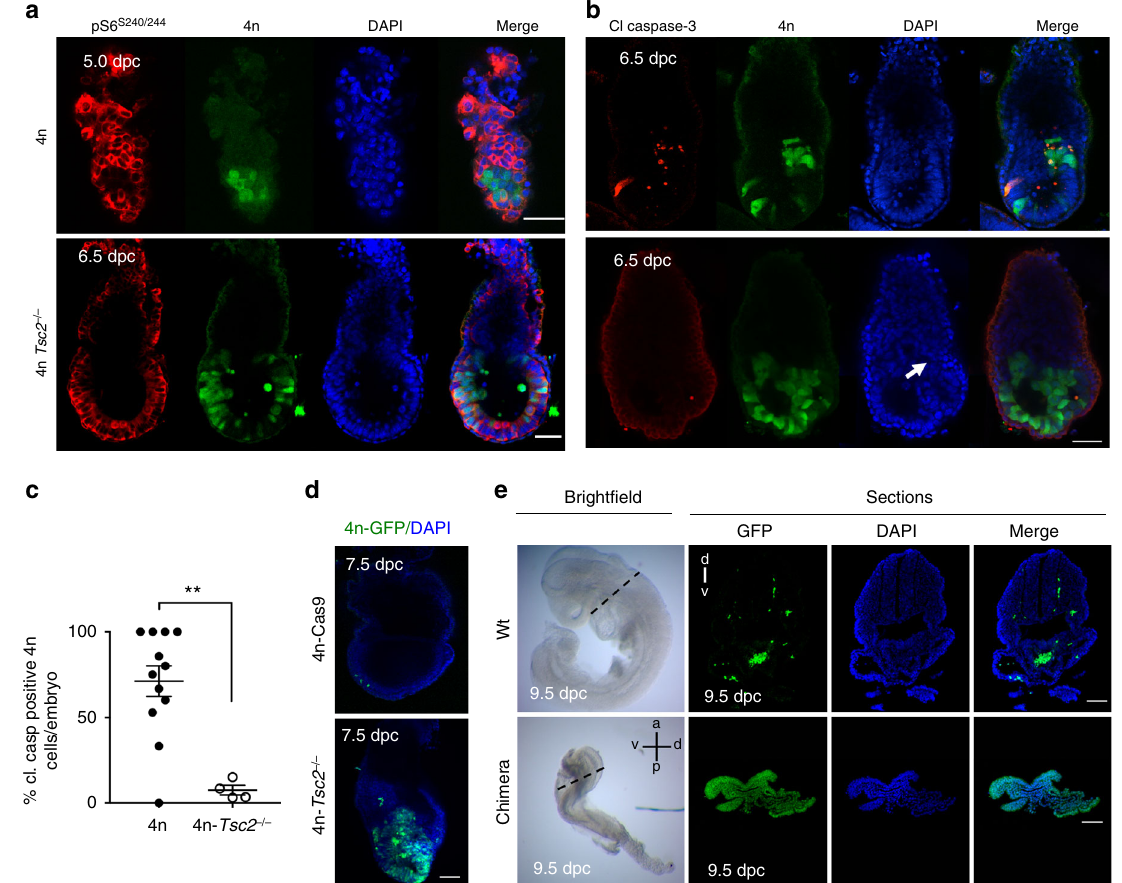
Fig. 5 mTOR pathway repression is required for competition in vivo. a Chimeras generated by injecting 4n and 4n- Tsc2 − / − cells into wild-type blastocysts. Levels of pS6 were analysed at 5.0 dpc and 6.5 dpc, respectively. b Chimeras generated by injecting 4n ( n = 12) and 4n- Tsc2 − / − ( n = 4) cells into wild-type blastocysts. The white arrow indicates epiblast overgrowth of 4n- Tsc2 – / – cells in these chimeras. Levels of cell death were assessed by cleaved caspase-3 staining at 6.5 dpc and quanti fi ed ( c ). d Chimeras generated by injecting 4n-Cas9-GFP and 4n- Tsc2 − / − -GFP cells into wild-type blastocysts. Embryos were analysed for GFP expression to determine contribution of 4n cells. e 4n- Tsc2 − / − GFP cells were injected into wild-type blastocysts, embryos were collected at 9 dpc, and levels of 4n Tsc2 − / − GFP contribution were assessed by whole-mount immuno fl uorescence or by sectioning. Morphology of chimera is compared to wild-type control embryo. Scale bars are 50 μ m for a , b and 100 μ m for d , e . Error bars denote SEM ( c ). ** p < 0.01; t